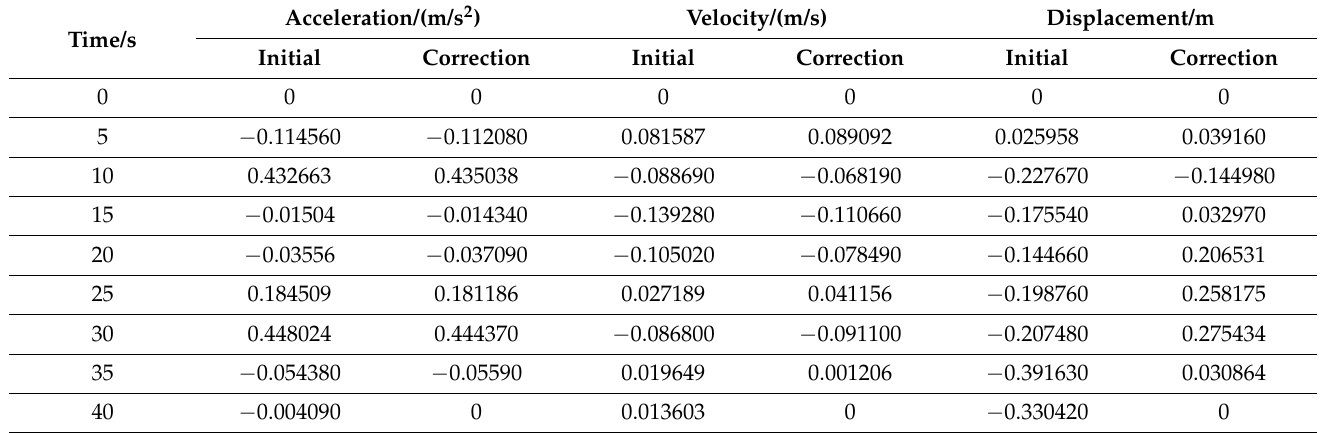
Table 2. Initial and corrected values at different